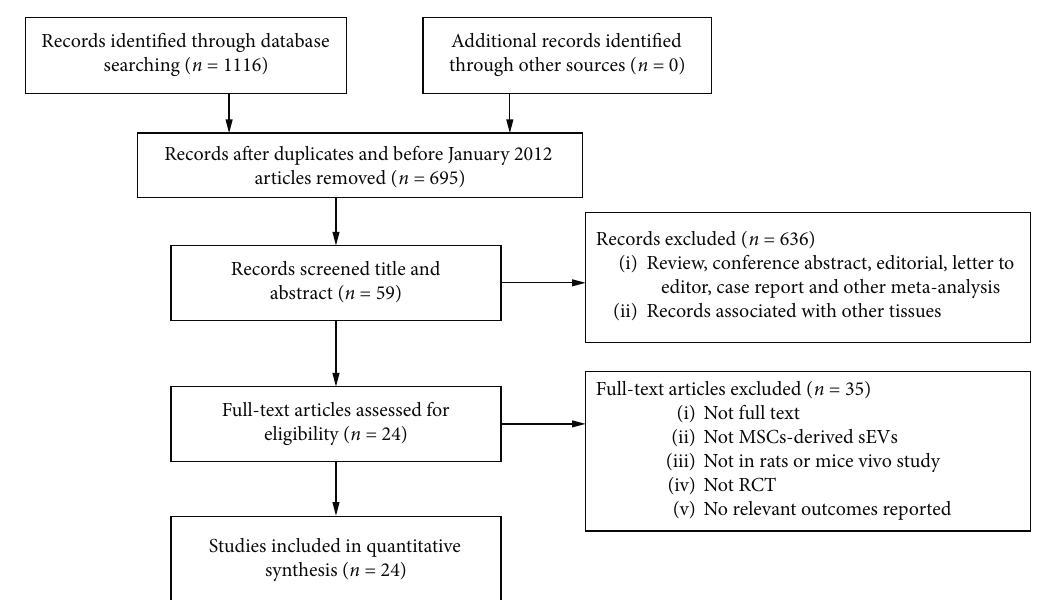
Figure 1: Flow chart of literature